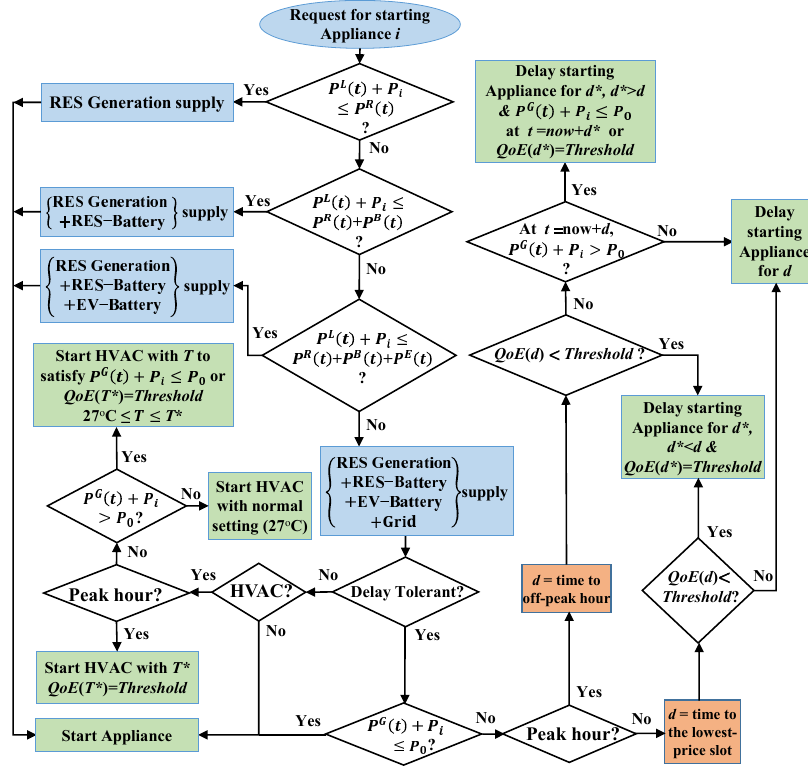
Figure 3. QoE-aware smart appliance control algorithm for